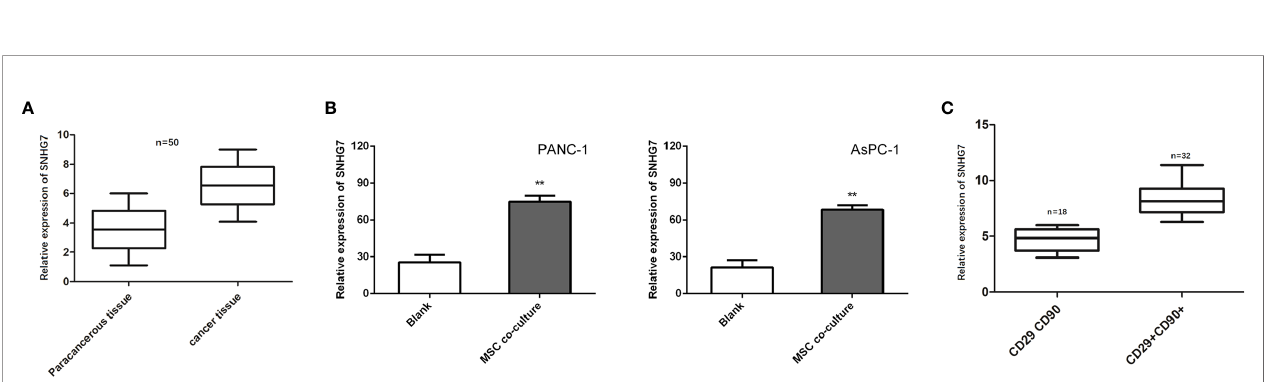
FIGURE 2 | Effect of MSC in xenograft models. (A) Nude mice were injected with PANC-1 cells, and tumor weight in mice of each group were assessed. (B, C) Quanti fi cation of IHC staining rate of CD29+CD90+ in non-tumorous specimens or pancreatic cancer specimens from patients at stages I/II and III/IV. **P < 0.01.